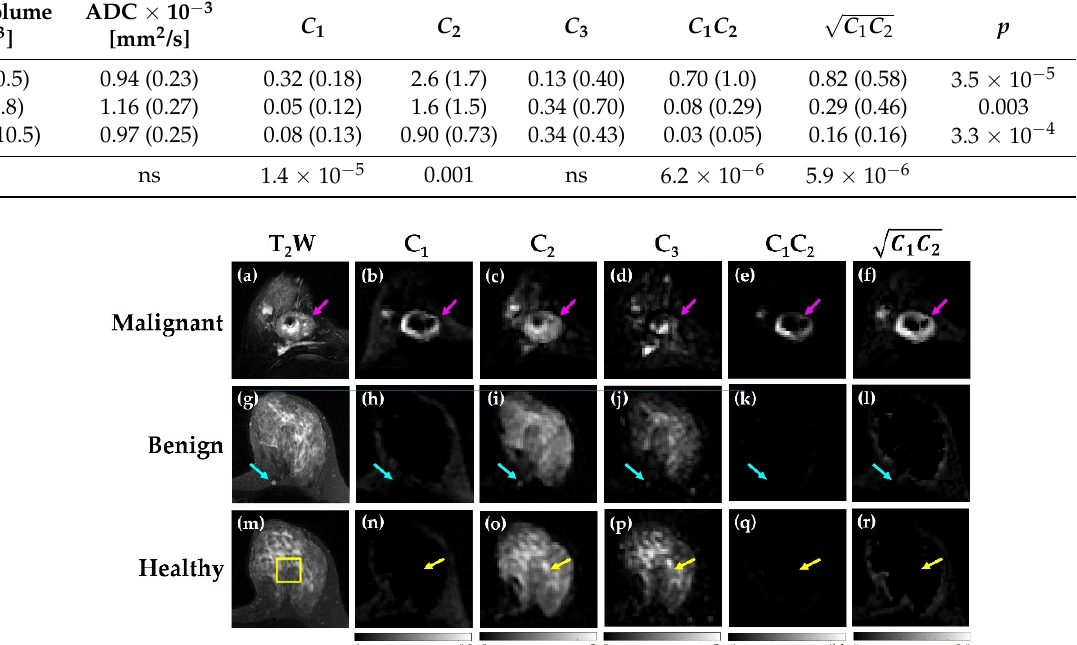
Figure 4. Representative maps for each compartment ( C 1 , C 2 , C 3 , C 1 C 2 , (cid:3493)𝑪 𝟏 𝑪 𝟐 ) , with ( a – f ) malignant lesions, ( g – l ) benign lesions, and ( m – r ) healthy tissue ROIs indicated. Malignant lesions had the highest signal contributions in the C 1 ( p < 0.001) compart- ment compared to benign lesions and healthy tissue, with median (interquartile range) values of 0.32 (0.18) for malignancy, 0.05 (0.12) for benign tissue, and 0.08 (0.13) for healthy tissue, respectively (Figure 5, Tables 2 and 3). In the C 2 compartment, benign lesions were not different from malignant lesions ( p = 0.30) or healthy tissue ( p = 0.90), but malignant lesions had higher ( p < 0.01) C 2 values compared to healthy tissue. The C 2 values